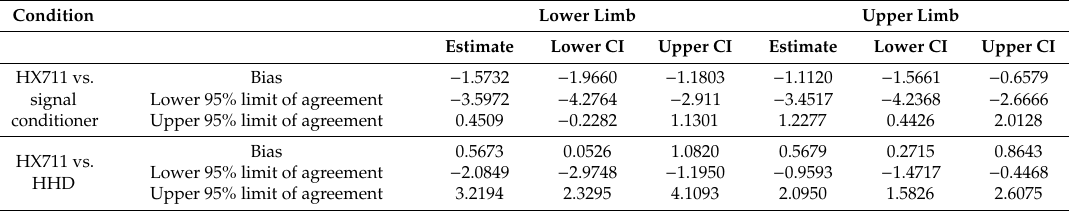
Table 3. Session two summary of the mean difference comparison results between two pairs of instruments for maximal isometric leg extension (lower limb) and maximal isometric bicep flexion (upper limb), including the mean difference, and the upper and lower 95% limits of agreement (mean ± 1.96 * SD). Condition Lower Limb Upper Limb Estimate Lower CI Upper CI Estimate Lower CI Upper CI HX711 vs. signal